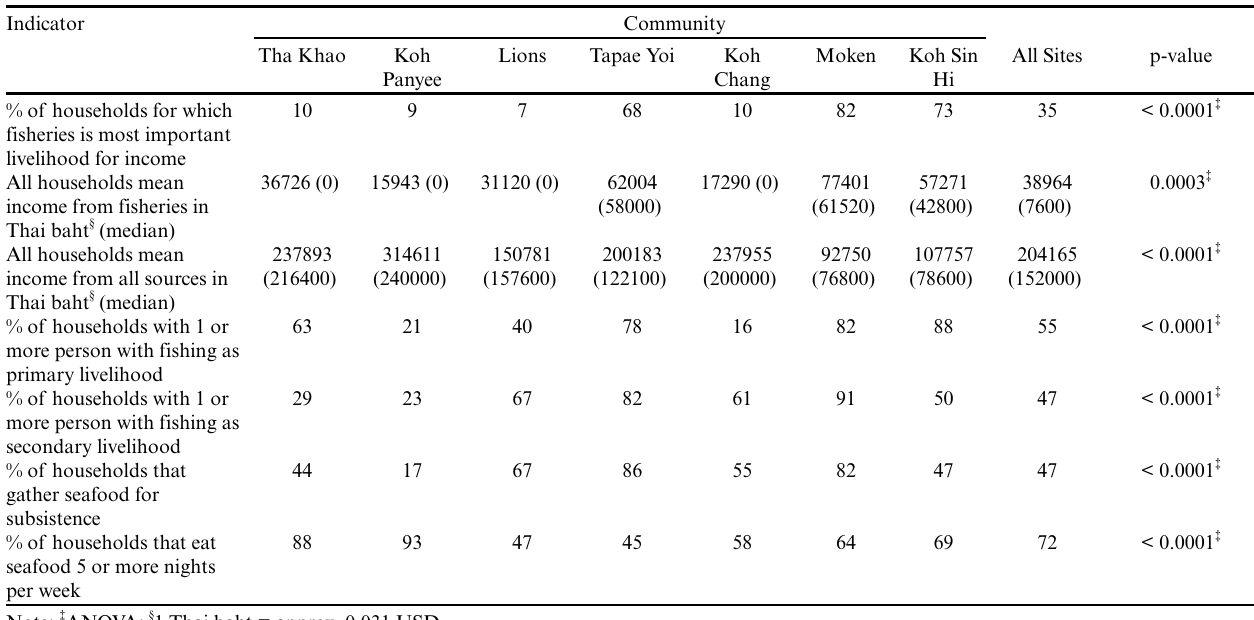
Table 4 . Importance of fisheries-based livelihoods to households (hh) for income, employment, and subsistence. Indicator